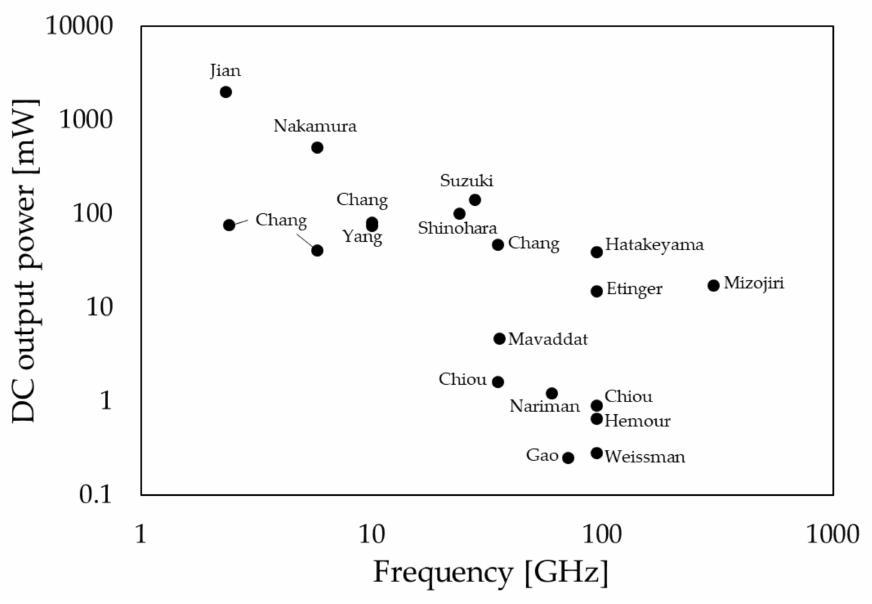
Figure 2. Earlier reports of studies assessing rectenna DC output power for frequency